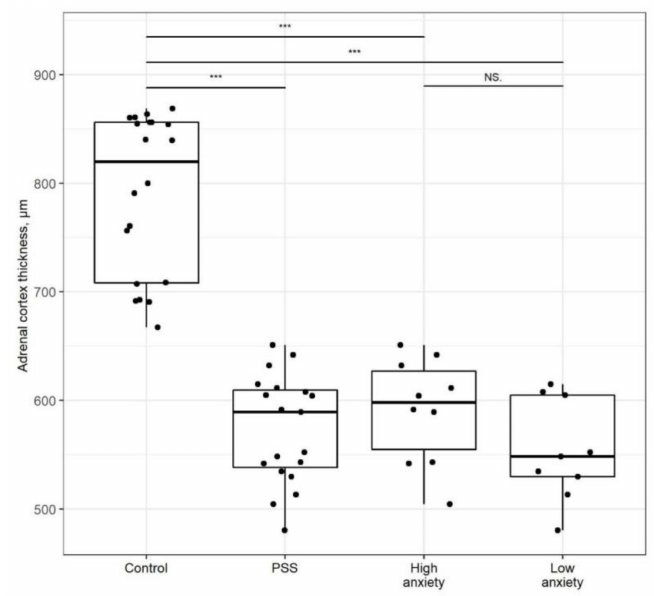
Figure 4. Adrenal cortex thickness is decreased after PSS . Adrenal cortex thickness of control, PSS, high- and low-anxiety PSS groups. Differences in adrenal cortex thickness values among groups are shown as boxplots with dots rep-resenting individual data values and medians shown by horizontal lines. The boxes include the central 50% of the data, i.e., from the 25th to the 75th percentile. The whiskers include the data contained within 1.5 times the interquartile range. NS = p > 0.05; *** p < 0.001. p values determined in non-parametric analysis.